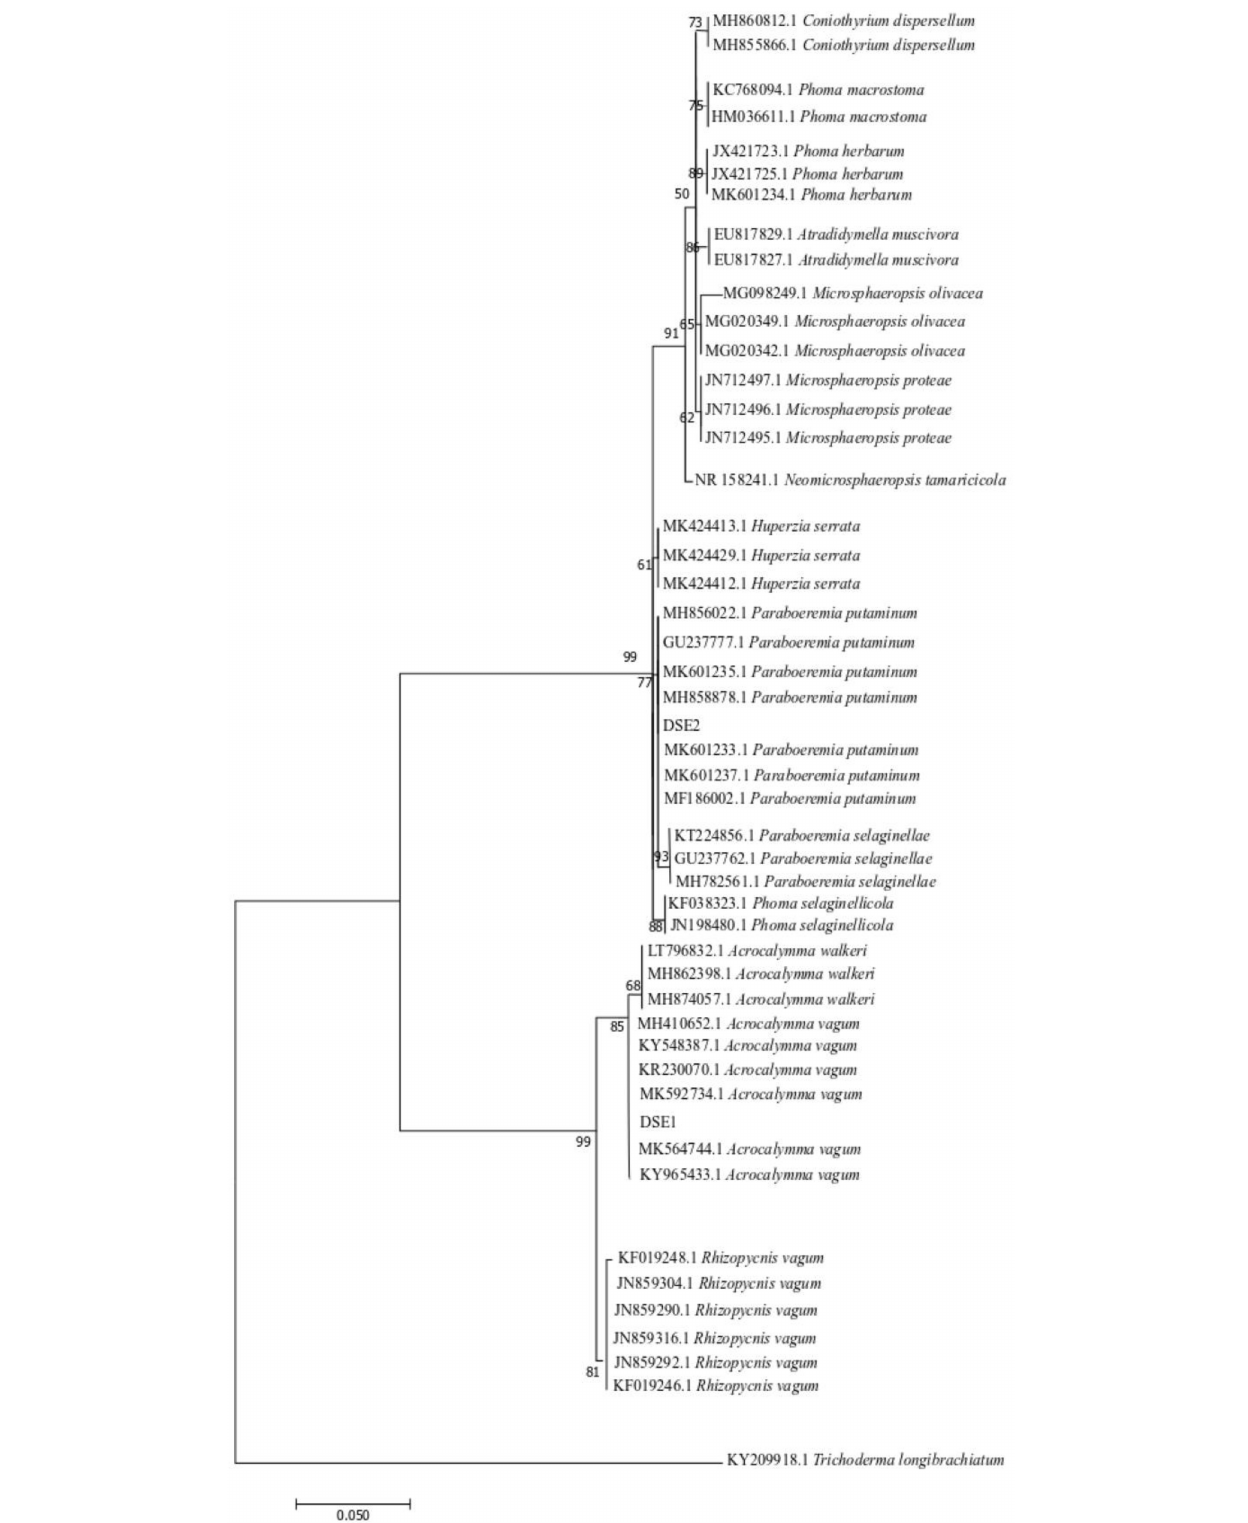
Frontiers in Microbiology |